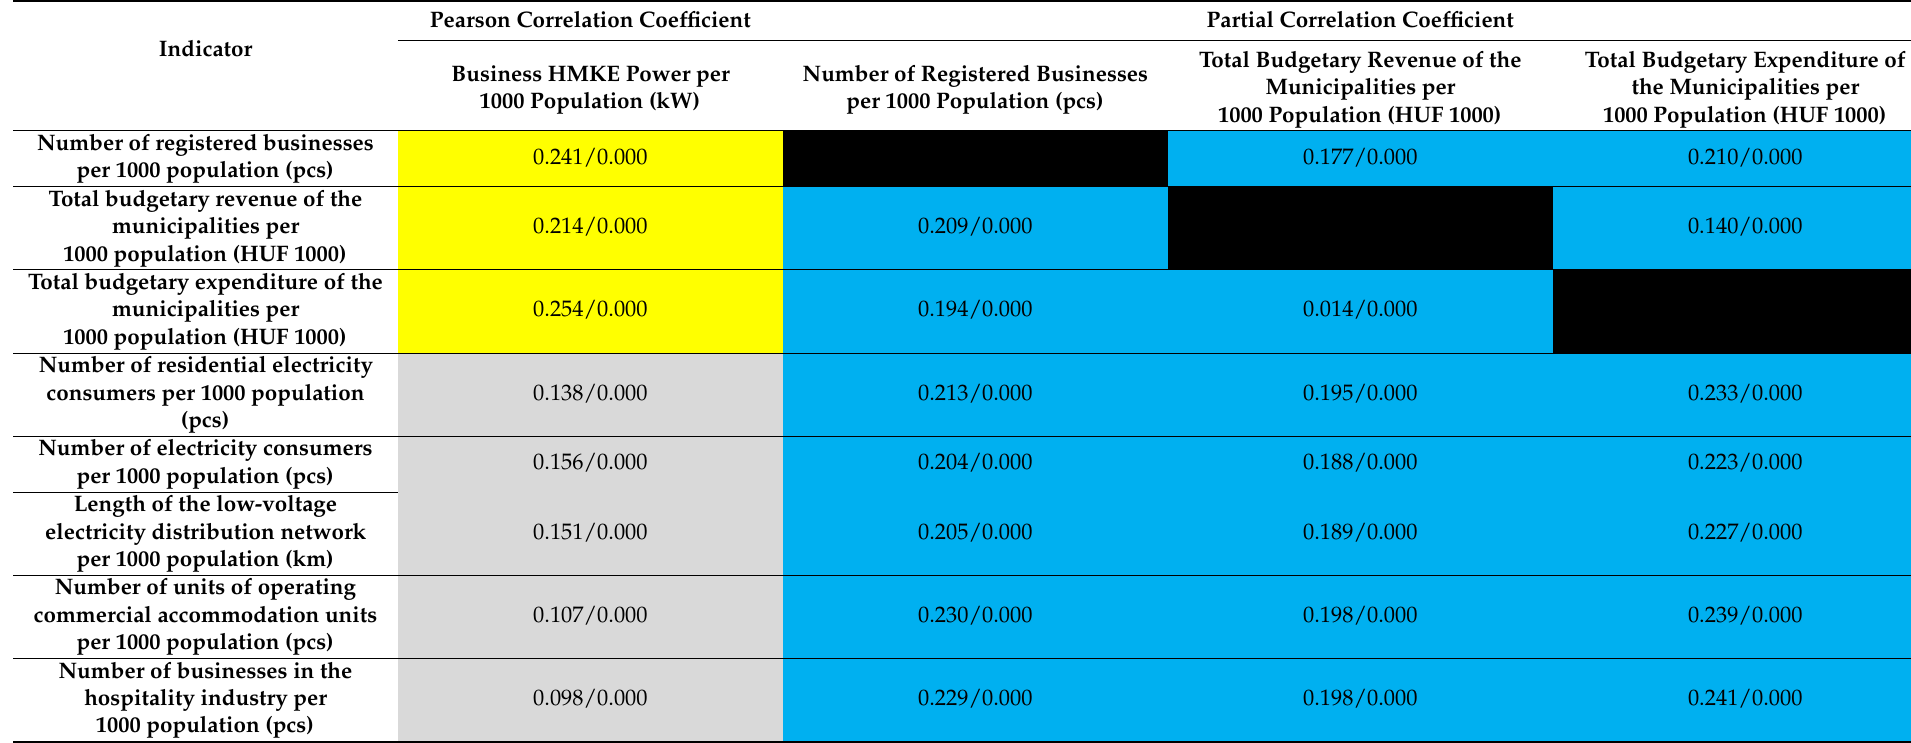
Table A4. The strengths of the relationships between the power of the business HMKEs per 1000 population and the settlement indicators 1 ( 1 Pearson correlation coefficient/ p -value; if p < 0.05, then there is a significant verified relationship between the two variables) (In the case of the Pearson correlation coefficients in the table grey background indicates weak correlations and yellow means weak moderate ones. In the case of the partial correlation the blue background signals partial explanation (the controlled variable explains the relationship between variables i and j only partially), while the black one shows irrelevant